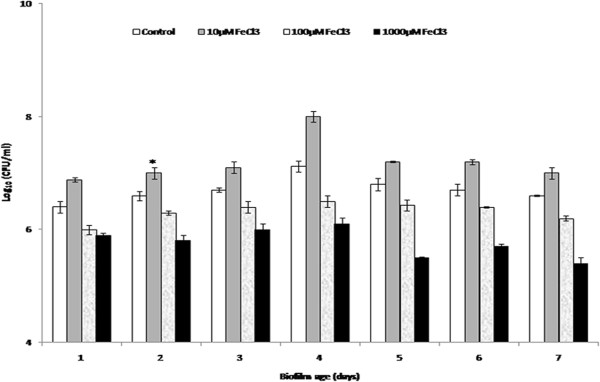
Kinetics of biofilm formation by K. pneumoniae B5055 grown in minimal media (M9) with or without supplementation of FeCl3. *p < 0.05 (10 μM FeCl3 vs control group).